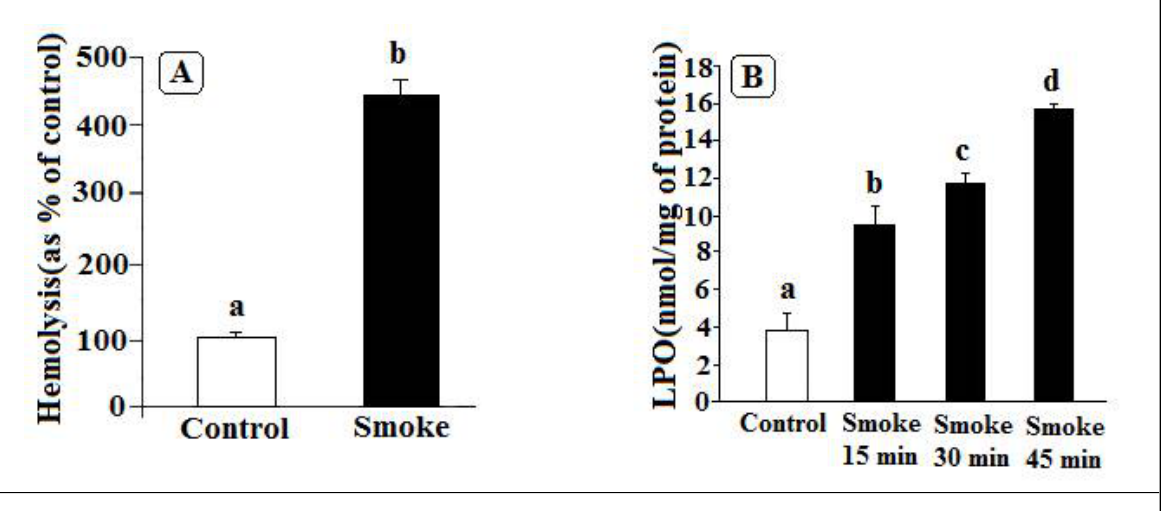
Figure 2: Acute exposure to cigarette smoke causes increased hemolysis and lipid peroxidation in vitro . (A) effect of in vitro cigarette smoking on hemolysis; and (B) time dependent lipid peroxidation of RBCs. Results are mean ± SEM ( n = 5). Bars with different letters are significantly different at p < 0.05